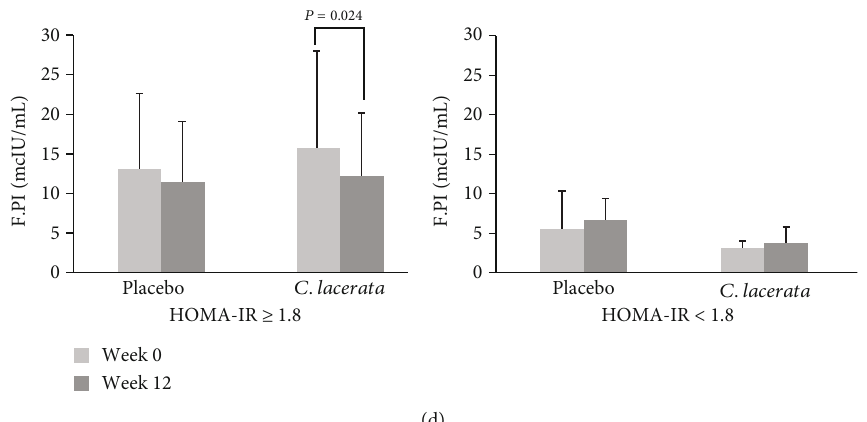
Figure 2: Subgroup analysis on the changes in (a) HOMA-IR, (b) QUICKI, (c) fasting c-peptide (F.C-pep), and (d) fasting plasma insulin (F.PI) between the placebo and C. lacerata groups after 12 weeks of intervention according to